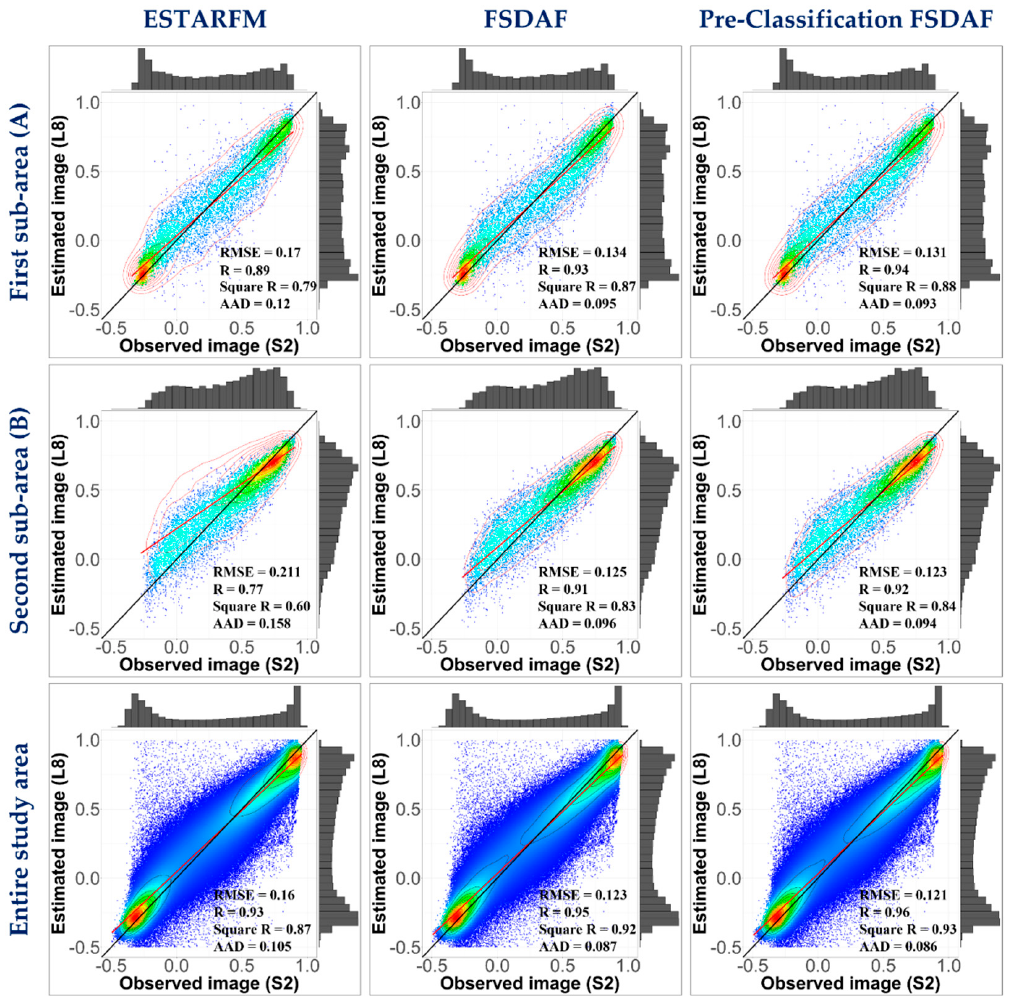
Figure 11. Scatter plots between the actual NDSI S2 image and its predicted image using the FSDAF, the ESTARFM, and the pre − classification FSDAF models over different sub-areas.